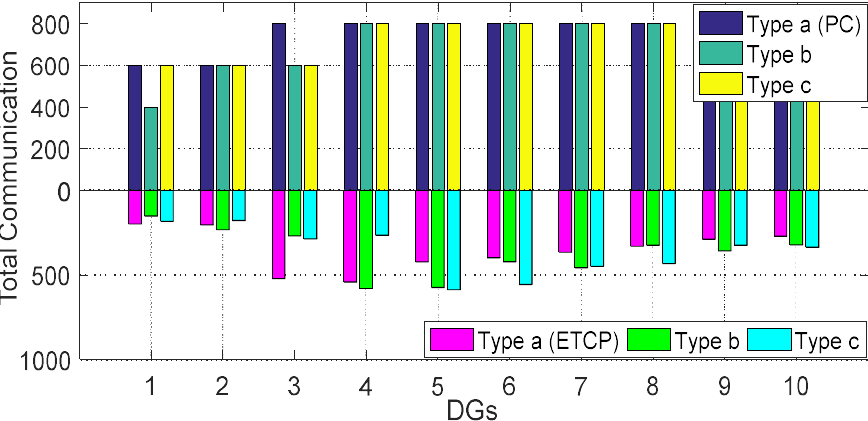
Figure 16. Total communication numbers of ETCP and PC under three types of communication failure.